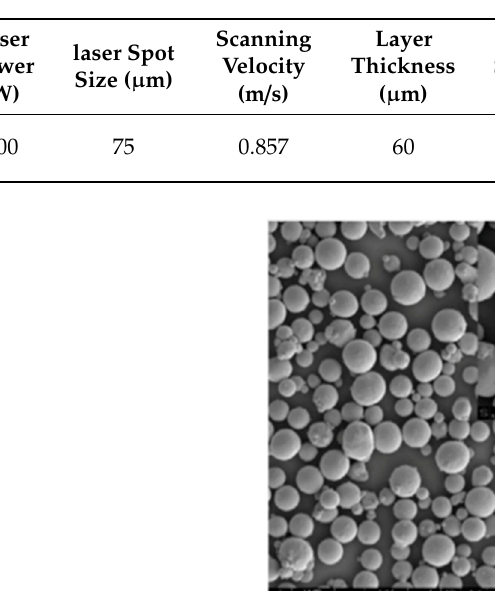
Figure 1. SEM micrograph of the surface morphology of powder used in the production of SLM specimens.